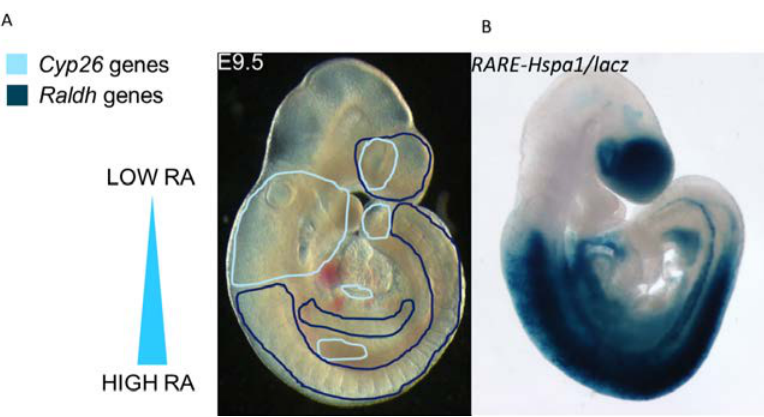
Figure 2. Overview of expression of retinoic acid regulating enzyme expression and retinoic acid signalling in mouse E9.5 embryos.( A ). Combined expression domains of RALDH1-3 retinoic acid synthesising enzymes (dark blue lines) versus CYP26A1, B1 and C1 retinoic acid degrading enzymes (pale blue lines) depicted on an E9.5 embryo. RA synthesising activity is mostly localised in the caudal part of the embryo due to RALDH2 expression in the paraxial and splanchnic mesoderm. RALDH1 and 3 contribute to small domains of expression around the developing eye and forebrain. CYP26 expression is mostly localised to the pharyngeo-cardiovascular tissues and hindbrain, with small regions of expression in the tail-bud and eye. This establishes a high to low postero-anterior RA gradient across the embryo, with varying expression in specific tissues modulating the exposue to RA further. ( B ). Beta-galactosidase staining in a wild type E9.5 RARE-Hspa1b/lacz transgenic mouse, giving a read-out of regions of retinoic acid signalling at this stage of development. Overall, regions of active RA signalling correspond to regions expressing RALDH RA synthesising enzymes, whereas those tissues expressing RA-degrading CYP26 enzymes are negative for RA signalling.